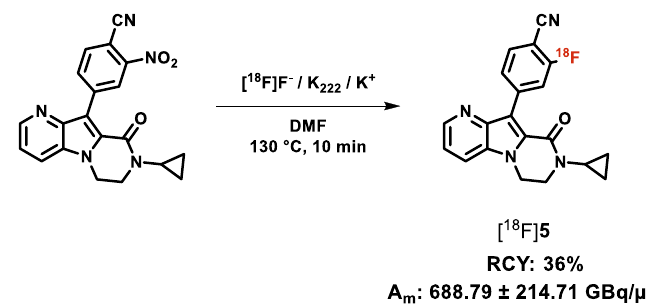
Figure 3. Molecular structures and IC 50 values for the PDE4 isoforms of ([ 18 F]) 5 [55], ([ 11 C]) 6 and ([ 11 C]) 7 [56,57], ([ 11 C]) 8 , ([ 11 C]) 9 , ([ 11 C]) 10 and ([ 11 C]) 11 [58], and the PDE4D inhibitor BPN14770 [59].